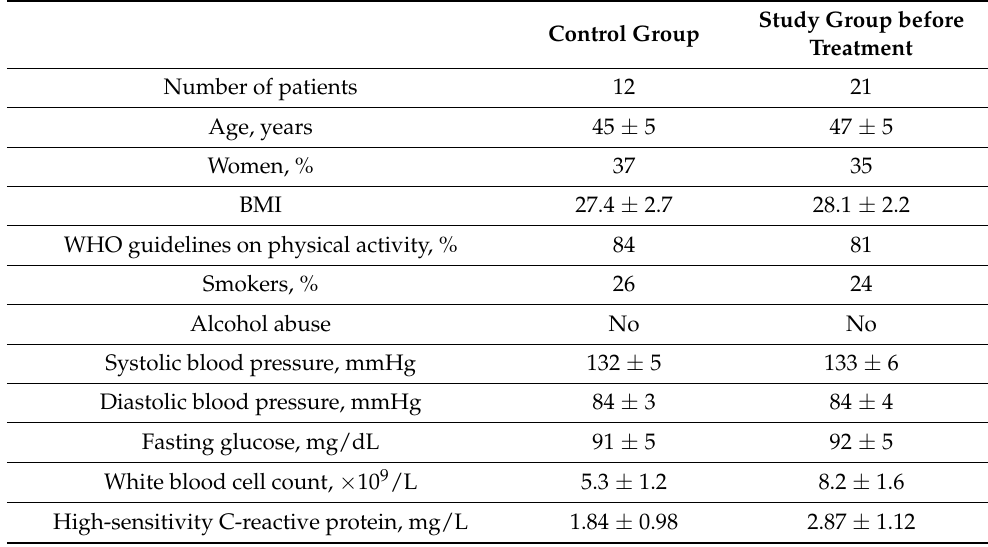
Table 1. Baseline characteristics of patients (values are mean ± SD unless indicated otherwise).